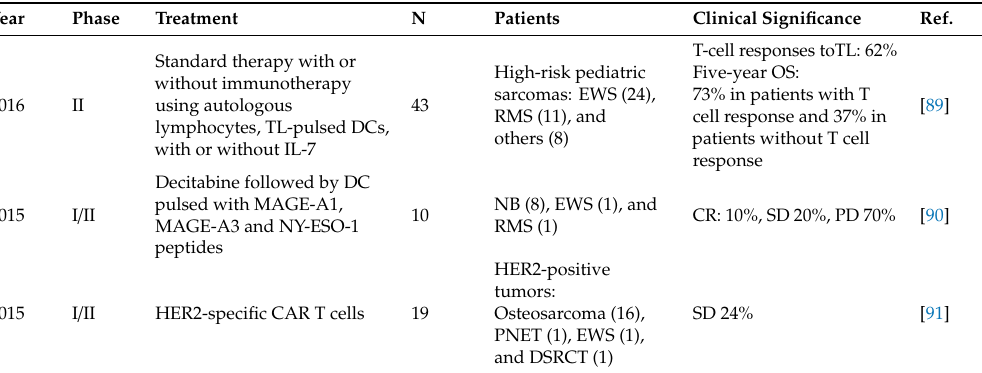
Table 3. Recent clinical studies on